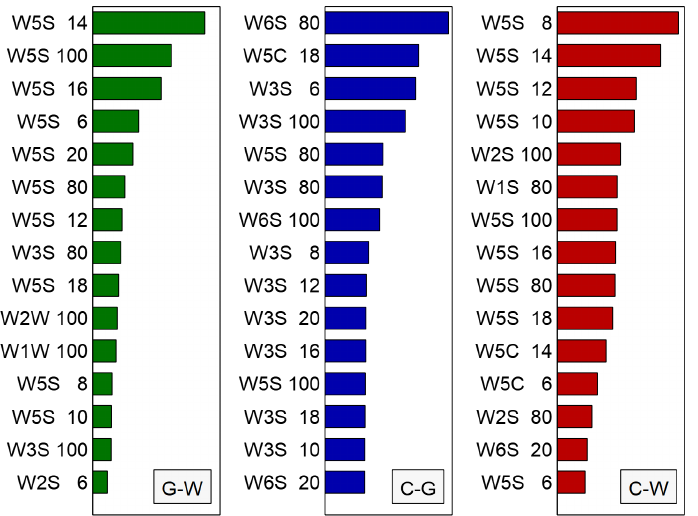
Figure 11. Visualization of the top 15 the most important modeling features selected by the ran- dom forest classification method for three considered binary classifications G-W-green vs. white, C-G-control vs. green, C-W-control vs. white. The x-axis has no meaningful units. The name of each feature represents the symbol of the sensor (e.g., W5S) and the time (seconds, e.g., 14) of the